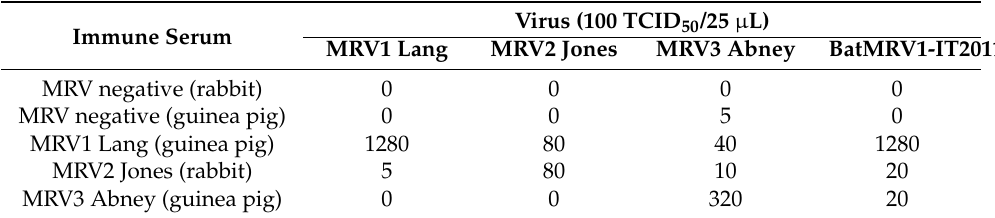
Table 2. MRV neutralizing antibody titers of rabbit and guinea pig sera produced against the